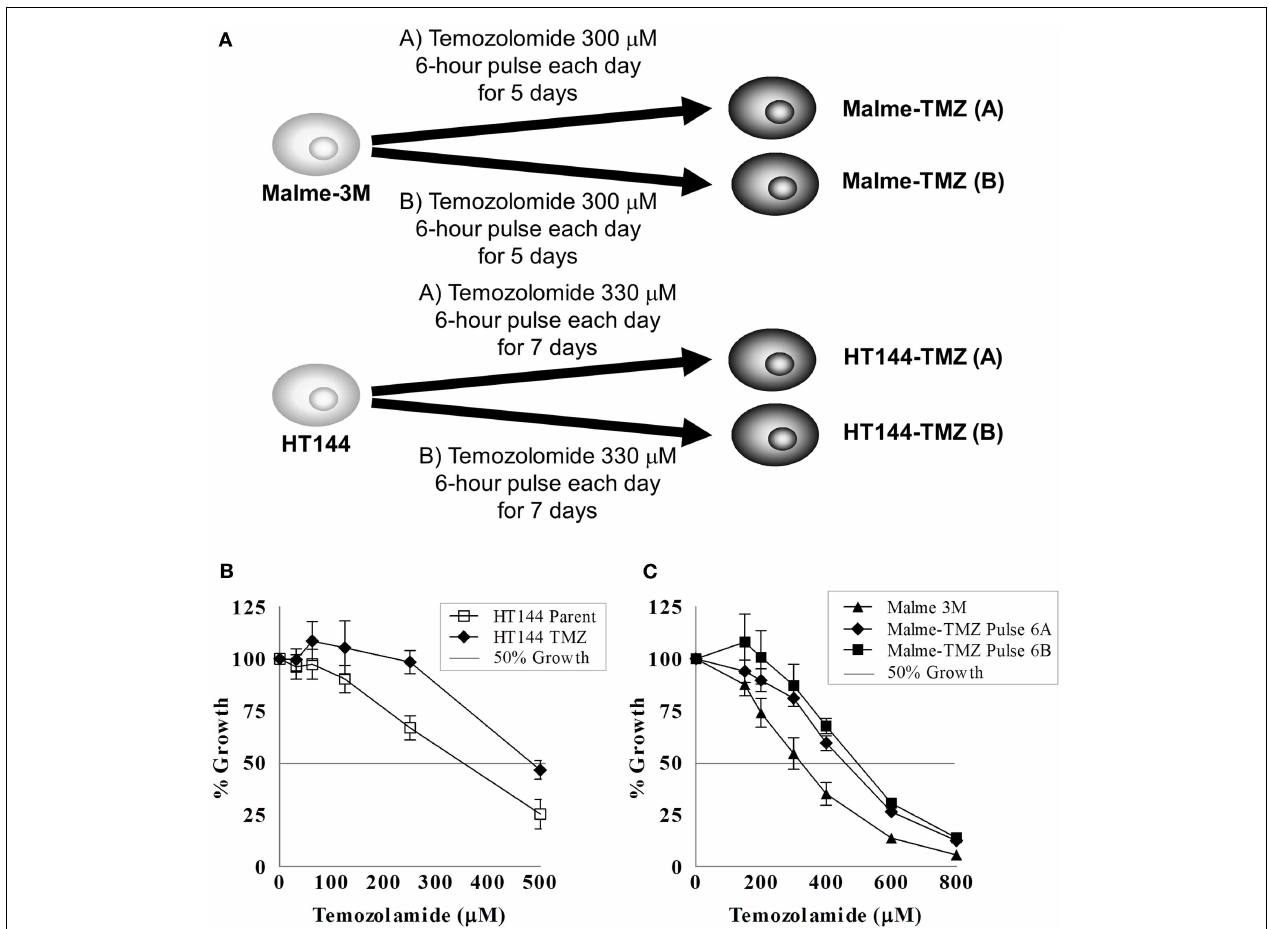
FIGURE 4 | Pulse selection of Malme-3M and HT144 with temozolomide . (A) Selection strategy of Malme-3M and HT144, each treatment of temozolomide was performed in duplicate. Effect of temozolomide in Malme-3M and HT144 and temozolomide “pulse selected” resistant variants. (B) Malme-TMZ(A) and Maleme-TMZ(B) vs. Malme-3M cells (C) . HT144-TMZ vs. HT144 cells. Error bars represent the standard deviation of triplicate